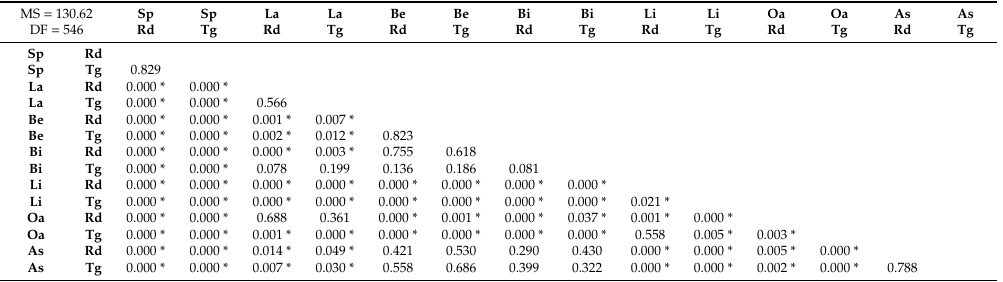
Table A1. Duncan’s Multiple Range Test for Modulus of Rupture.